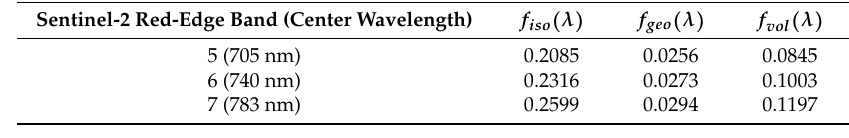
Table 3. Sentinel-2 MSI red-edge band BRDF spectral model parameters derived by linear interpolation between the red and NIR MODIS BRDF spectral model parameters (Table 1).